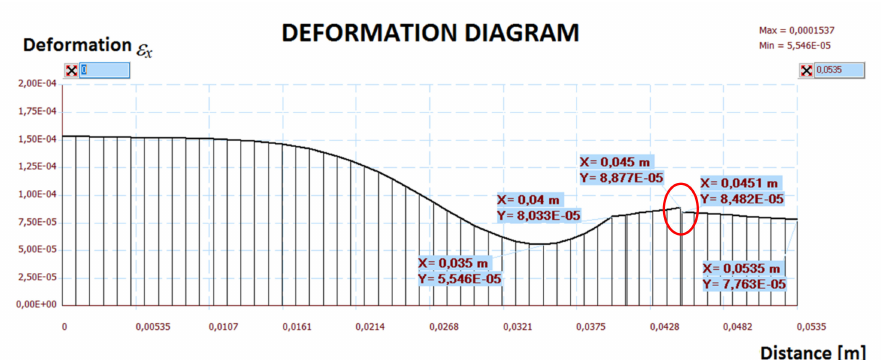
Figure 21. The map of horizontal deformations ε x .